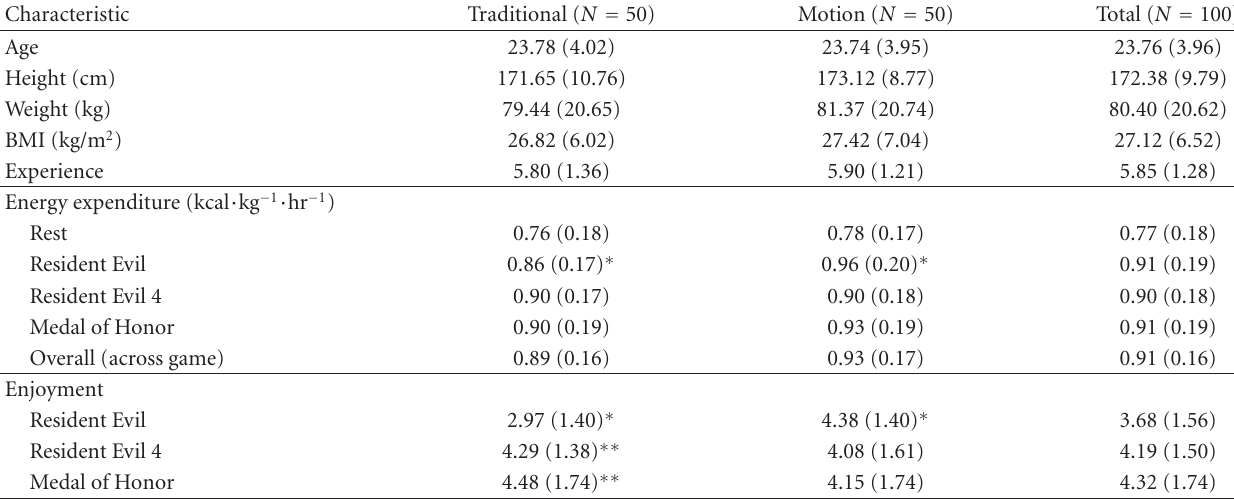
Table 1: Participant characteristics and energy expenditure and enjoyment outcomes by condition, mean